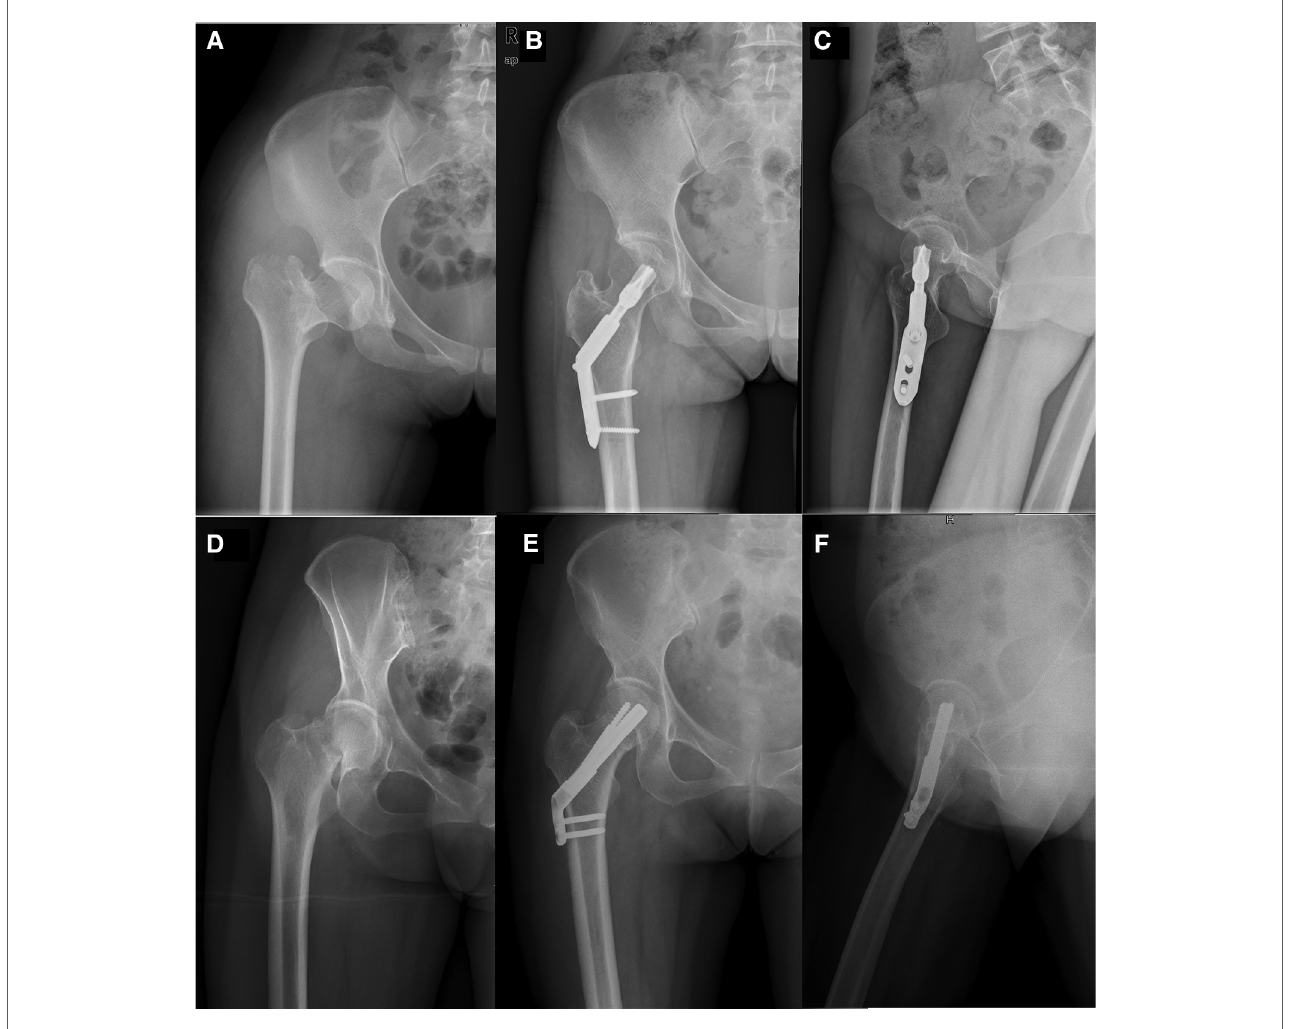
FIGURE 1 Two internal fi xation methods for femoral neck fracture. A 48-year-old female received Dynamic hip system blade fi xation after 20 months ( A – C ) and A 50-year-old female received femoral neck system after 19 months ( D – F